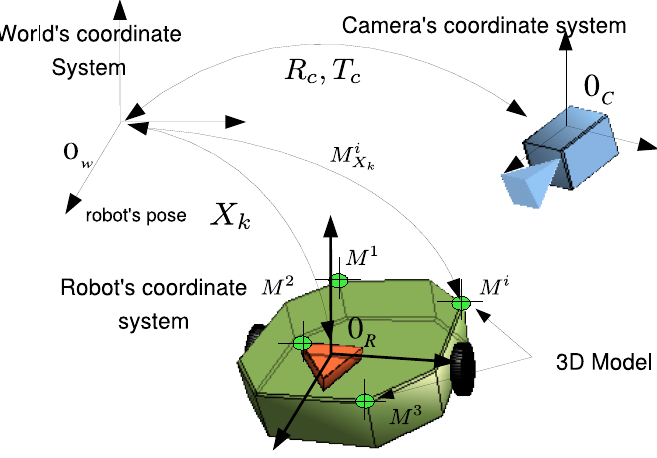
Figure 2. Spatial relationship between world’s coordinate origin O origin O and camera’s coordinate origin O R